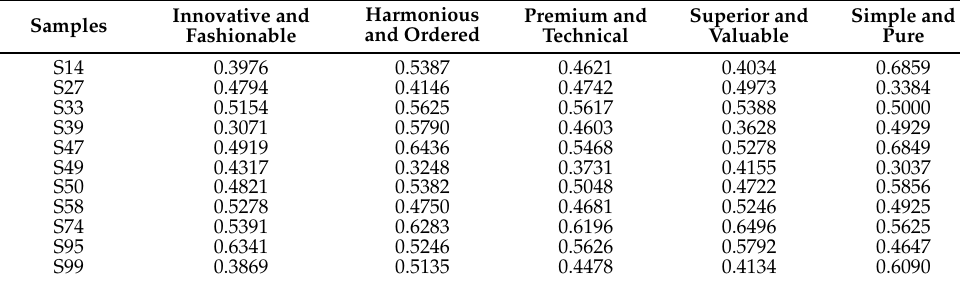
Table 11. The total utility values of 11 samples of smartphone rear cameras.